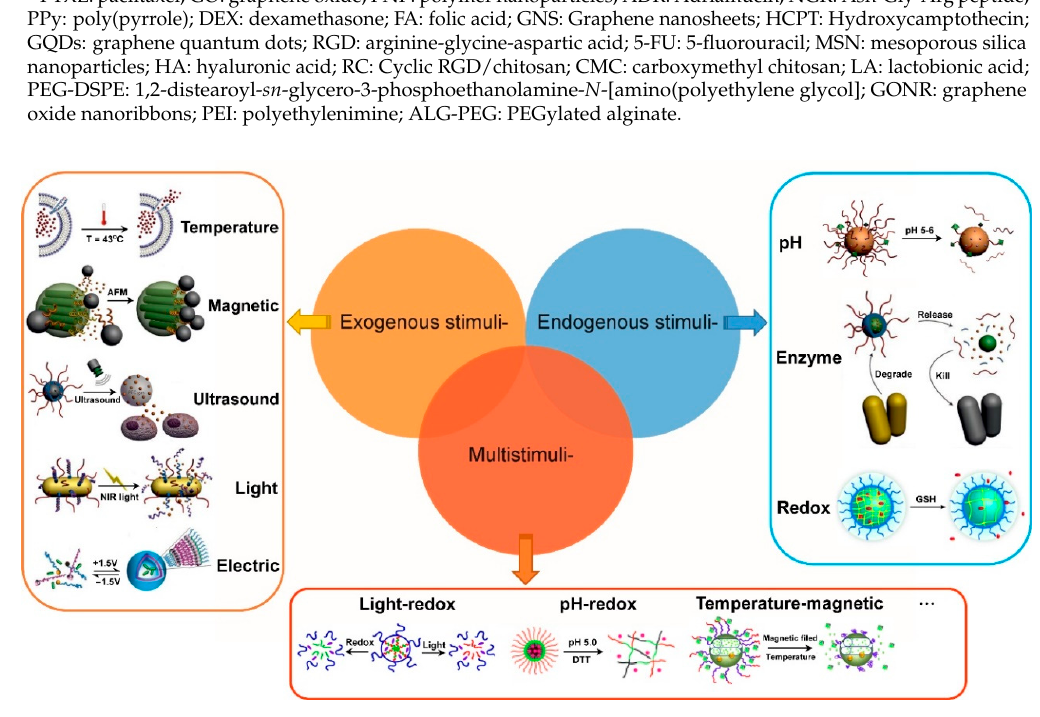
Figure 1. Ways of controlled drug delivery for various biomedical applications. AMF: alternating magnetic fields; NIR: near-infrared irradiation; DTT: dithiothreitol.